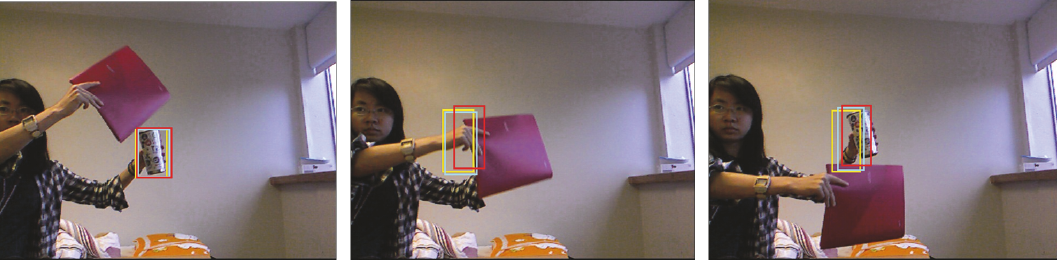
Figure 3: The comparison results on cup book video from PTB dataset.